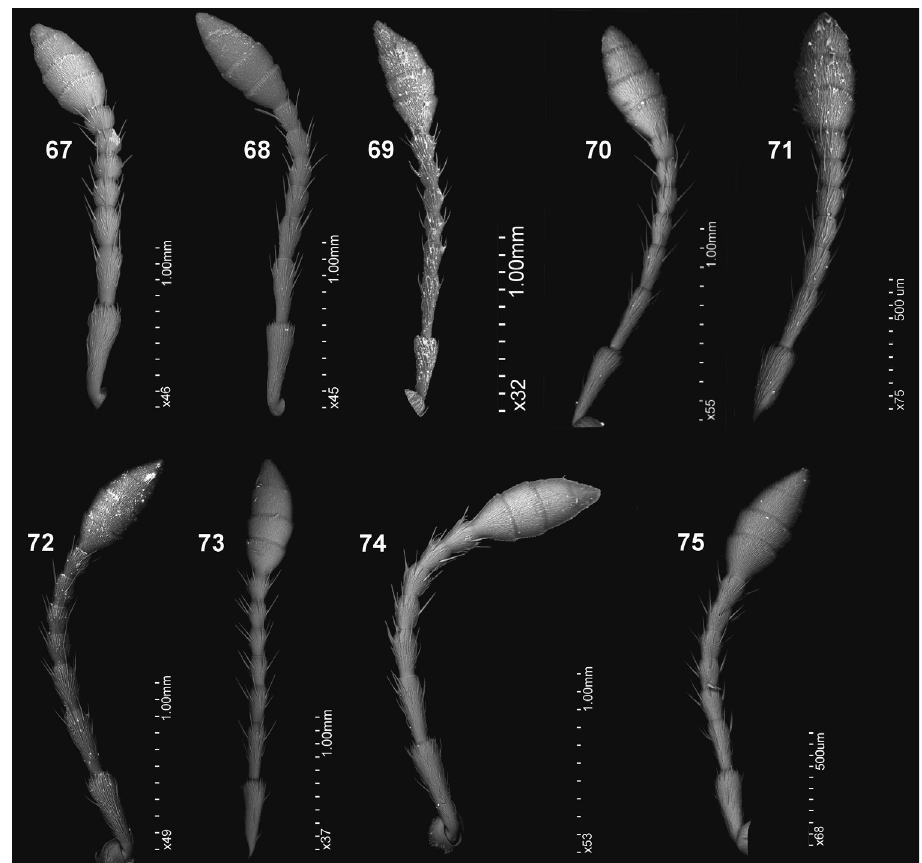
Figures 67–75. Antennae: 67 C. farinosus Perr. 68 C. fundatus sp. n. 69 C. gibbus sp. n. 70 C.